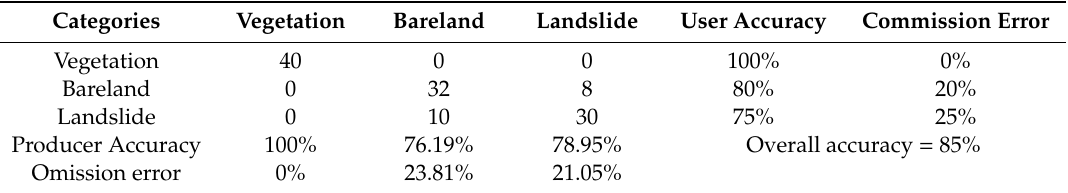
Figure 7. The thematic of spectrum analysis (green: vegetation, red: landslide and white: bareland). Table 1. Error matrix for spectrum analysis.